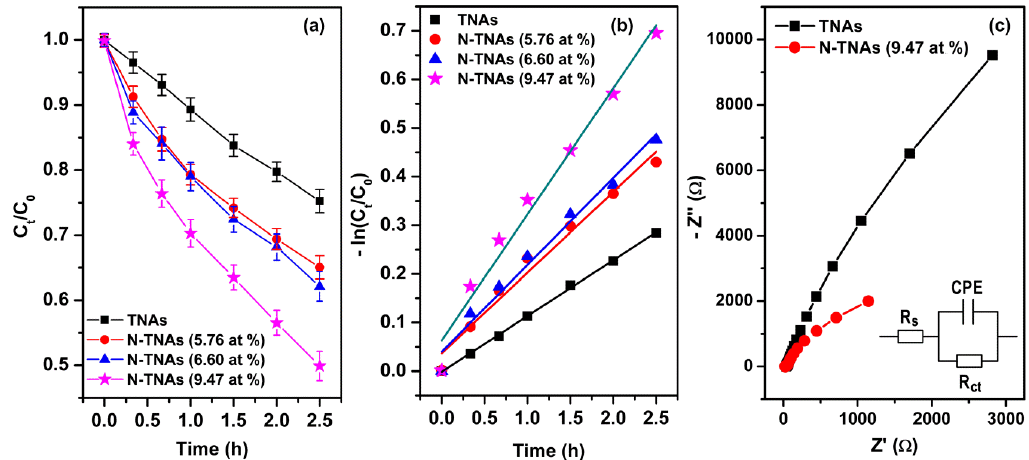
Figure 6. ( a ) Photocatalytic activity of TNAs and N-TNAs recorded in 0.5 ppm methylene blue solution under visible light illumination; the error bar indicates standard error of the mean data of three sample series. ( b ) Methylene blue degradation kinetic curves of TNAs and N-TNAs with different N-doping concentrations under visible light illumination. ( c ) EIS Nyquist plots for a TNA and a N-TNAs (9.47 at %) under visible light irradiation.; the inset is the equivalent fitting circuit. Table 2 summarizes the synthesis methods of N-doped TiO 2 -based nanomaterials and their photocatalytic performance in degradation various organic pollutants under light irradiation. The photocatalytic degradation rate of the N-TNAs (9.47 at %, k = 0.26 h −1 ) in this study was twice as high than that of N-TNAs (k = 0.11 h −1 ) [22], N-TiO 2 nanowires (k = 0.13 h −1 ) [63], and CdS – Ag/TiO 2